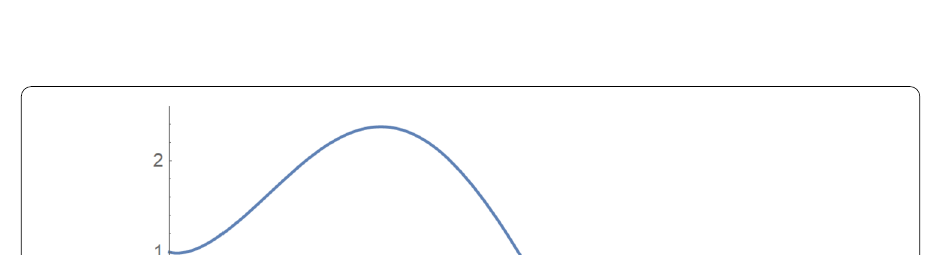
Figure 3 Solution of the problem for α = 0.5